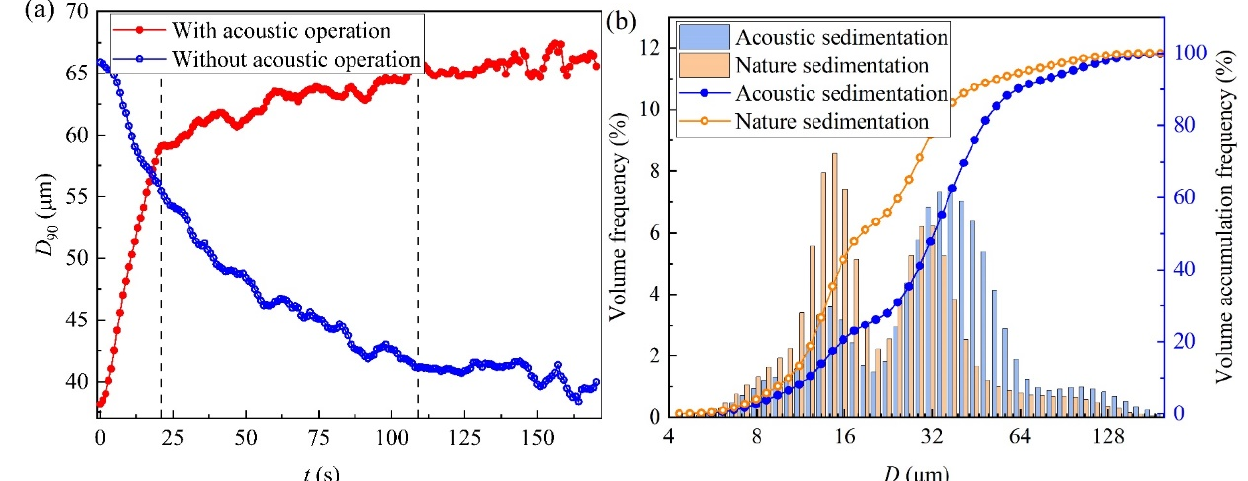
Figure 2. ( a ) Variations in D 90 and ( b ) micro-droplets size spectrum and its cumulative frequency.